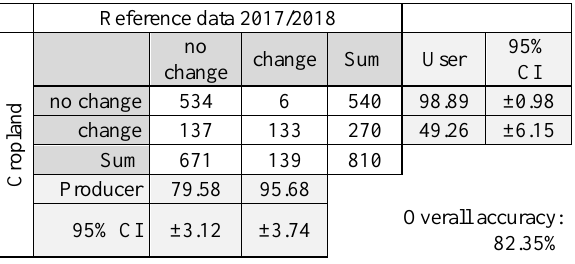
Table 3 . Confusion matrix for change layer Crop land. The confusion matrix for change layer “Homogeneous grassland” is given in Table 4. In total, the change layer has 1,436 change polygons with an average size of 2.33 ha. In total, the change layer has 1,436 change areas with an average size of 2.33